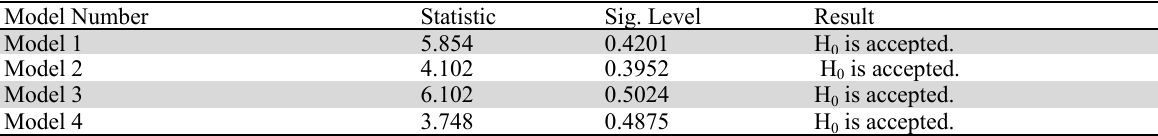
The Summary Results of Housman